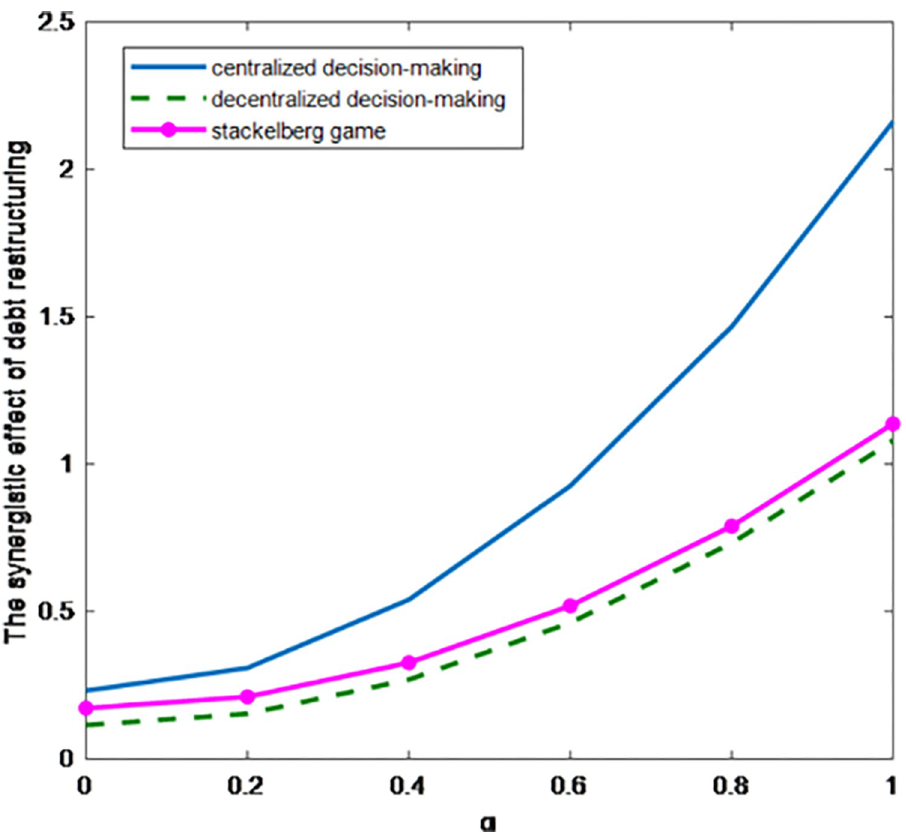
Fig 6. Influence of parameter α on the synergistic effect of debt